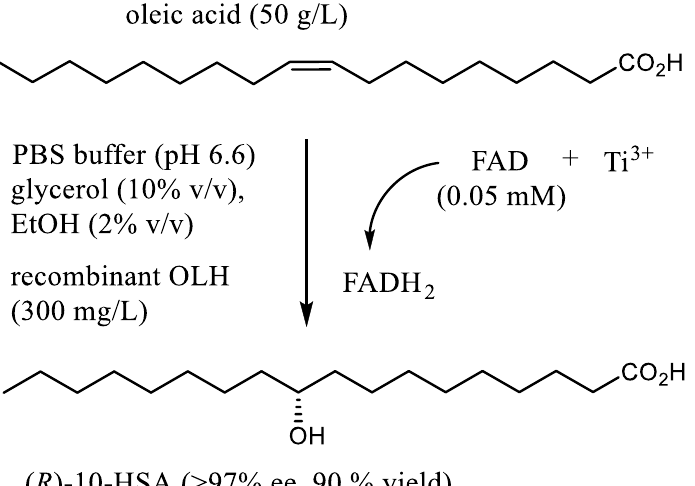
Figure 3. The preparative synthesis of ( R )-10-hydroxystearic acid through hydration of oleic acid by means of recombinant oleate hydratase and FADH 2 as cofactor.